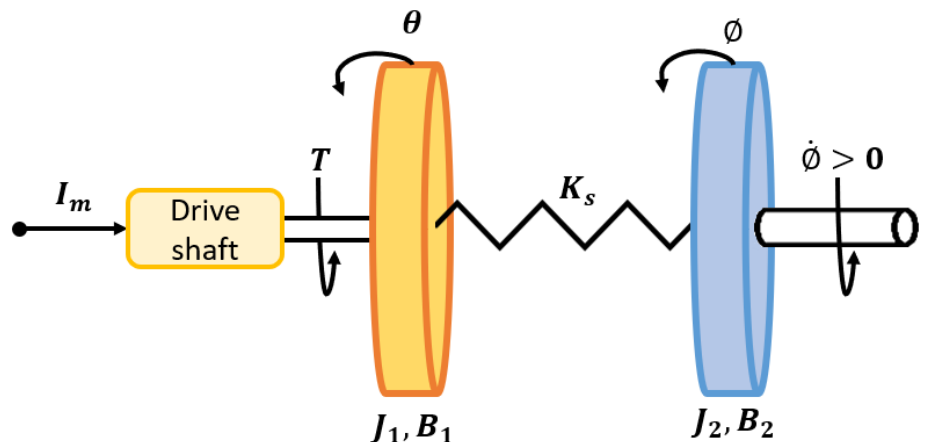
Figure 5. Single Flexible link mechanical